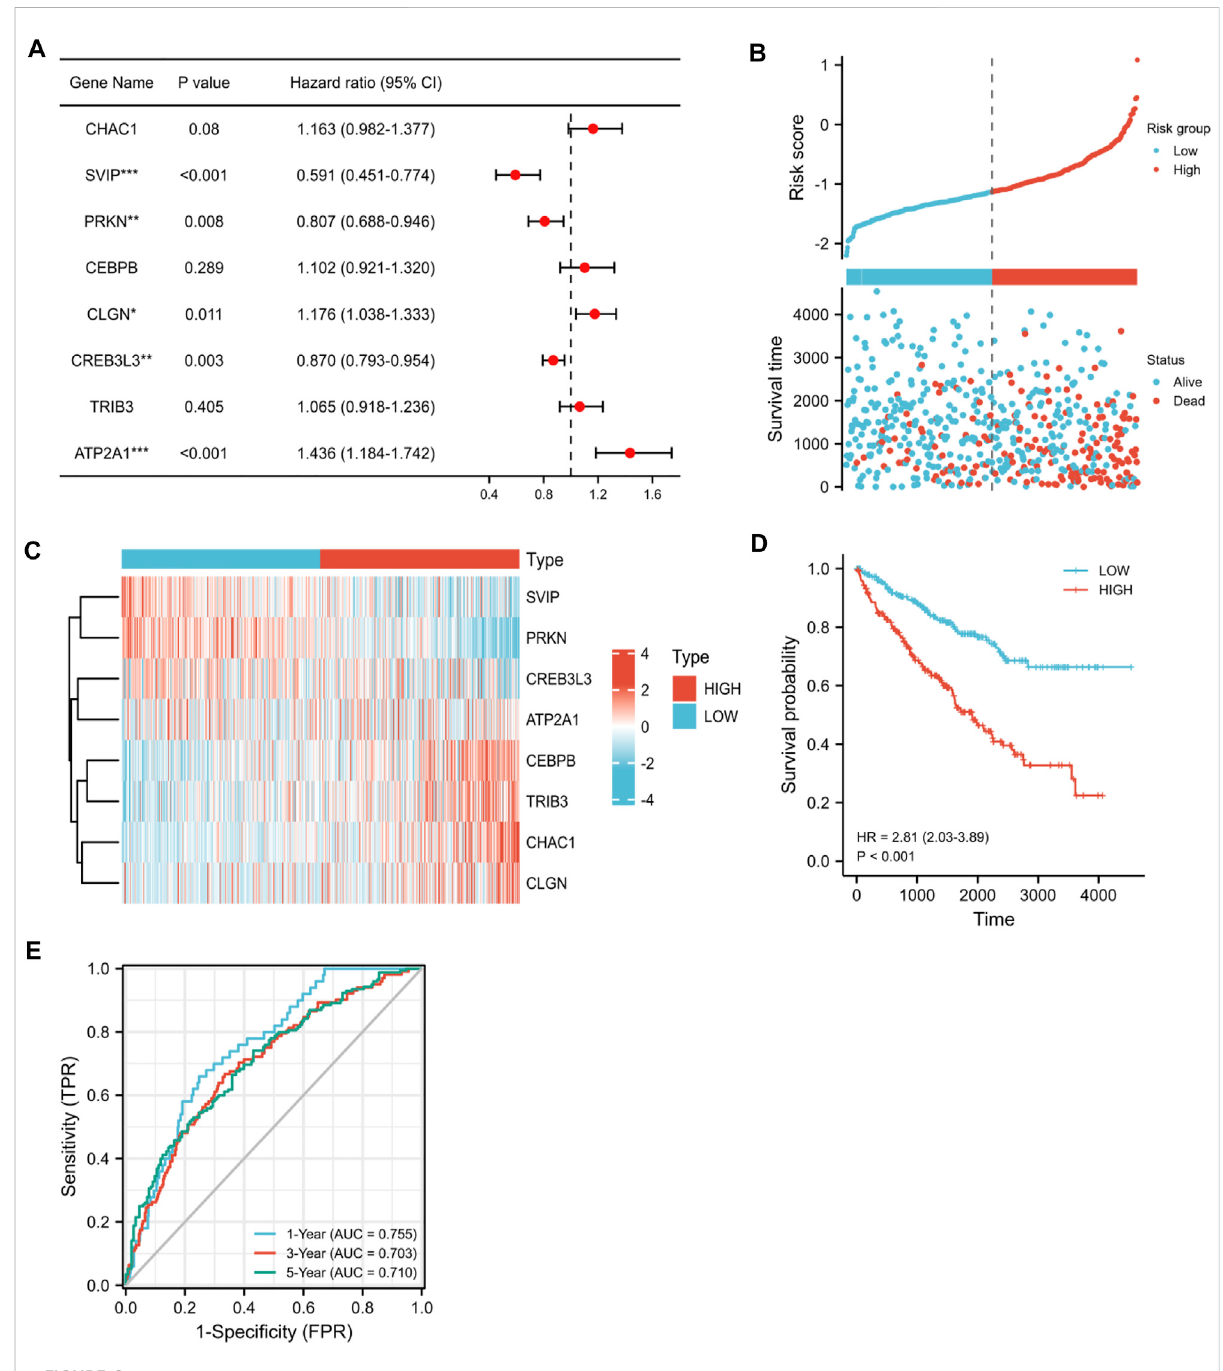
FIGURE 6 Correlation between the eight candidate ER stress-related DEGs and the prognosis of KIRC. (A) Multivariate Cox regression analysis of eight candidate ER stress-related DEGs. (B) Ranked dot and scatter plots showing the risk score distribution and patient survival status. (C) Heat map visualized upregulated and downregulated eight candidate ER stress-related DEGs between two risk groups in tumor specimens. Red means upregulated genes, and blue means downregulated genes. (D) K-M analysis of the OS between the two risk groups. (E) ROC curves to predict the sensitivity and speci fi city of 1-, 3-, and 5-year survival, according to the risk score. (* p < 0.05, ** p < 0.01, and *** p <